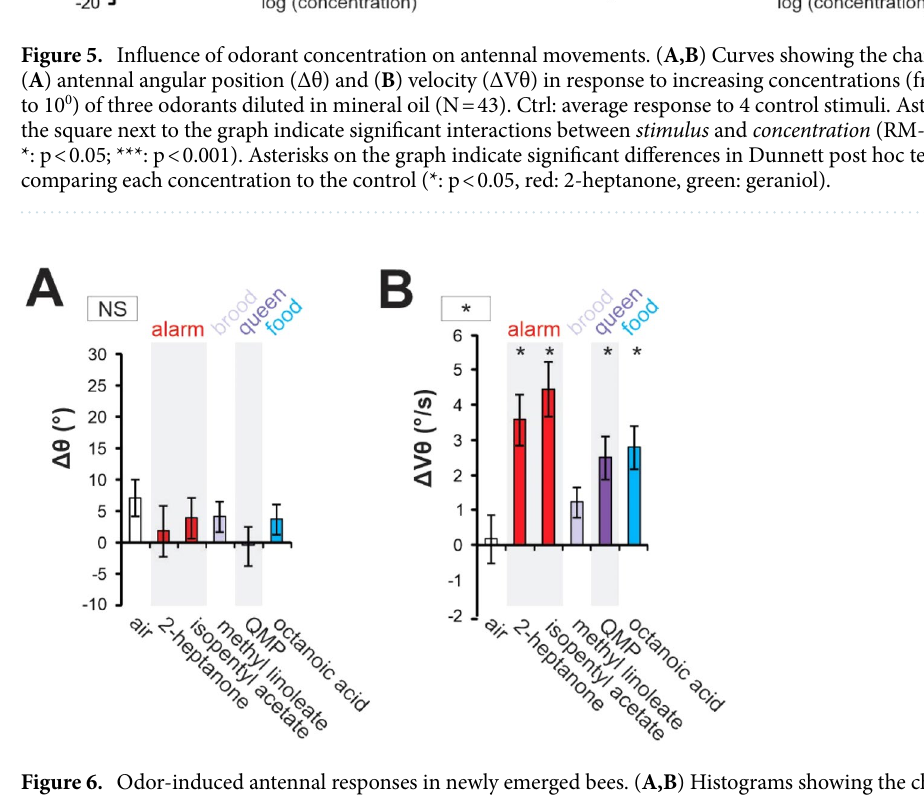
premotor center mediating fast and innate reactions to biologically relevant stimuli, and may be responsible for innate antennal movements to odorants. Direct connections between the LH and the AMMC are not described yet in honey bees, but they are known in fruit flies 91,92 . Changes in odor-induced antennal responses through experience (like after associative conditioning) would involve the MB, the learning and memory center of the insect brain. In the MB, the Kenyon cells (KC) are highly odor-specific and are activated by the combinatorial input from many different PNs 93 . Information from KCs is read out by MB-output neurons which project to different parts of the protocerebrum, including the LH. MB-output neurons are plastic and their odor-induced responses are modified by experience 94–97 . Some of them, like the PE1 neuron, project to the LH 95,98 and may be responsible for an experience-driven modulation of odor-induced antennal movements through this structure. To our knowledge, no direct connections of MB output neurons to the AMMC have been described 98 , but indirect pathways other than through the LH are possible.